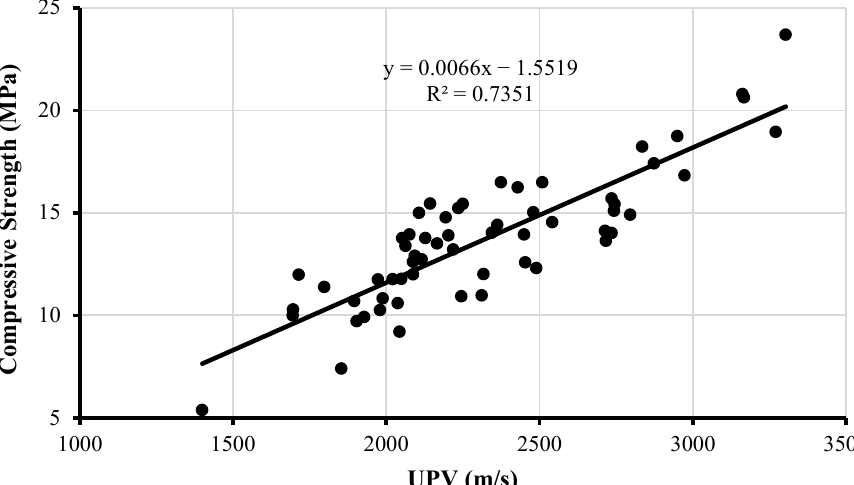
Figure 6. UPV vs. compressive strength.